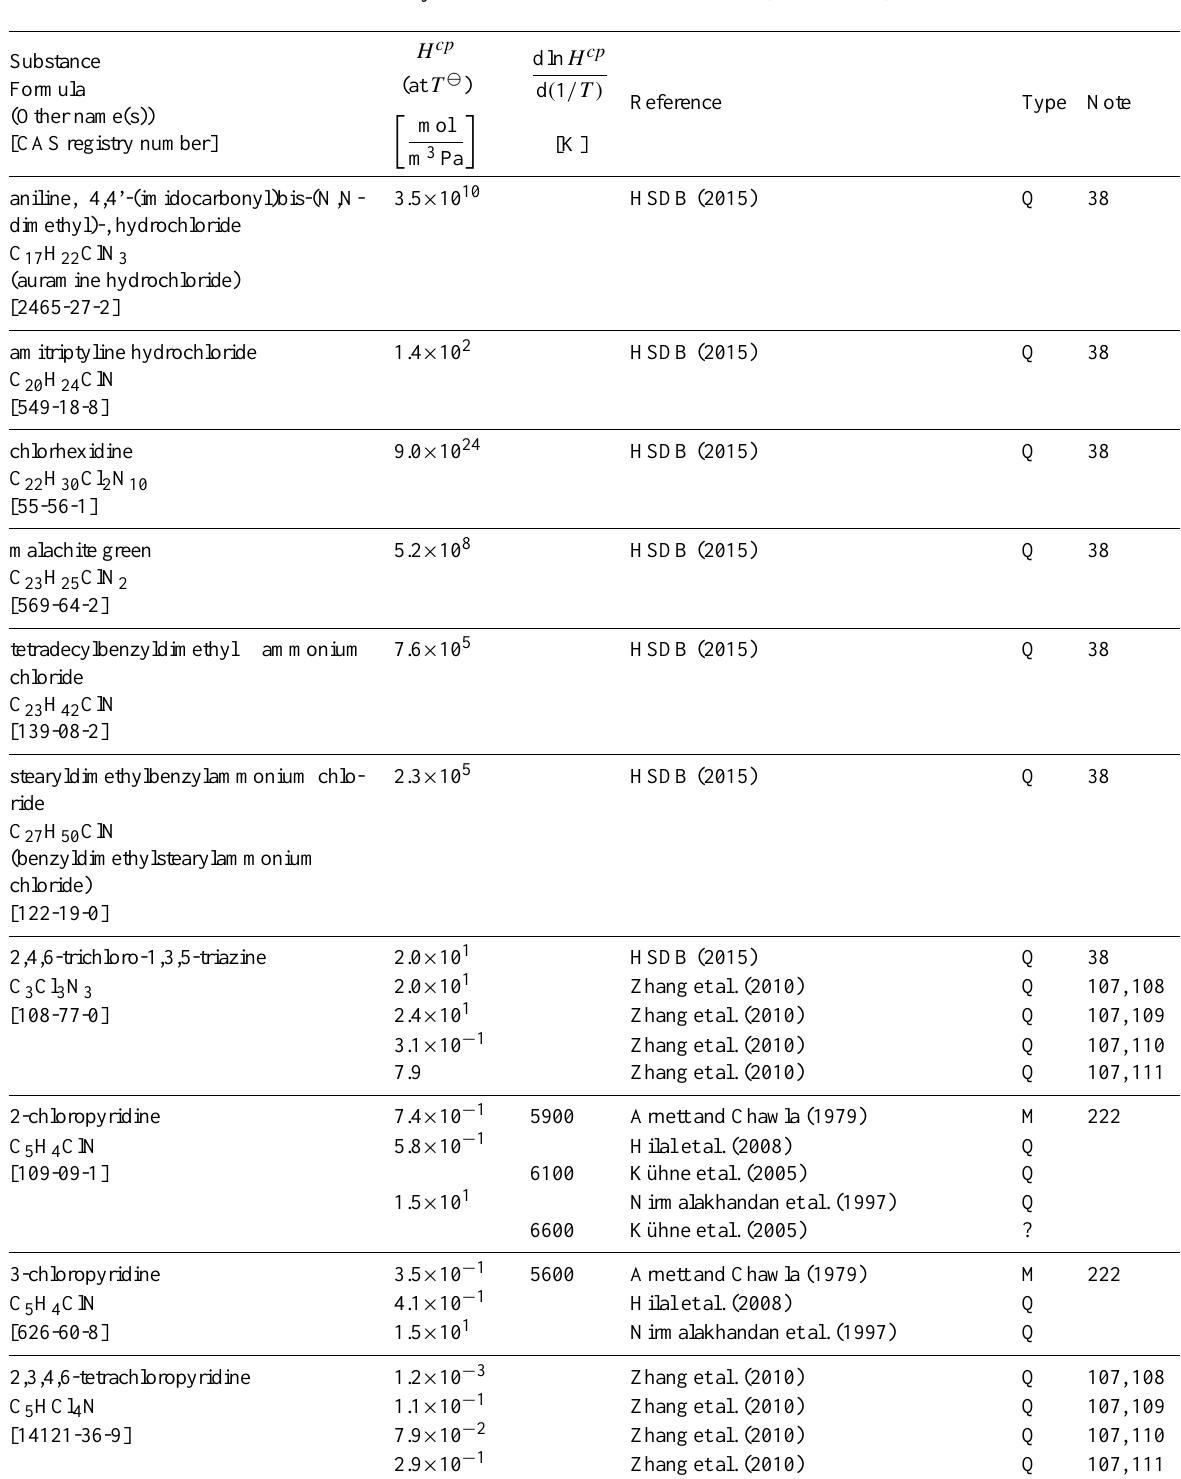
Table 6: Henry’s law constants for water as solvent